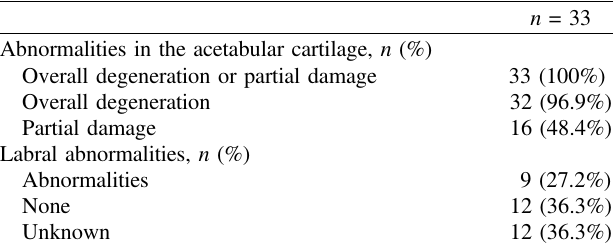
Table 2. Prevalence of abnormalities in the acetabular cartilage and labrum.